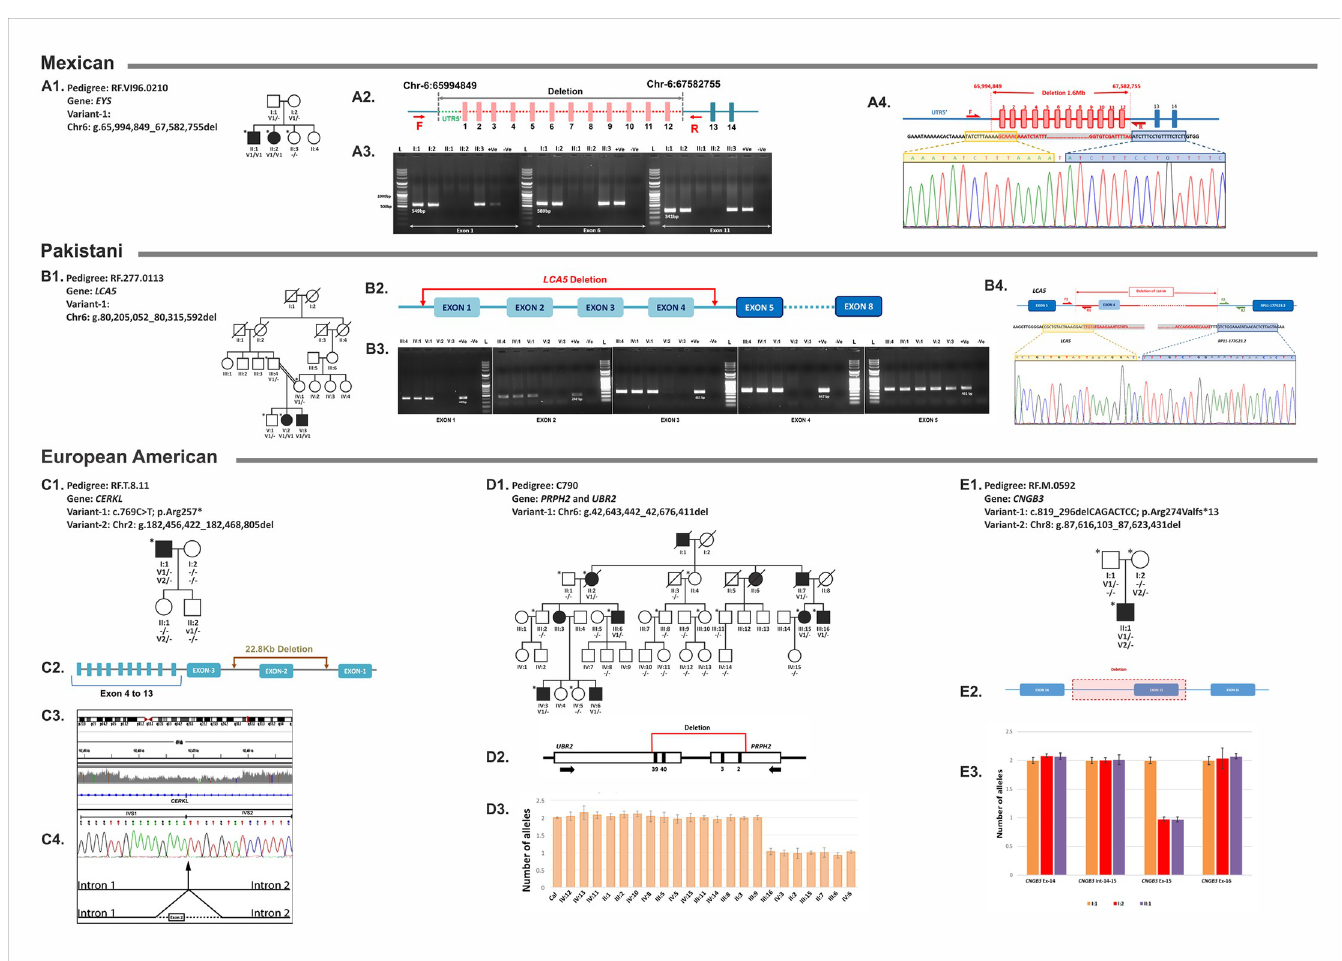
Fig 3. Pedigrees with copy number variations (CNVs). Five unique structural variants were identified in EYS , LCA5 , CERKL , PRPH2 , and CNGB3 in five different pedigrees, one with dominant macular degeneration and four with recessive retinal degeneration. (A1) 1.6Mb homozygous deletion Chr6: g.65,994,849_67,582,755del is segregating with recessive retinal degeneration in a Mexican pedigree RF.V196.0210. (A2) The schematic diagram depicting a 1.6Mb homozygous deletion Chr6: g.65,994,849_67,582,755del encompassing the exons 1 to 12 and about 1.6Mb of 5’-untranslated region of the EYS gene. (A3) PCR amplification of EYS exons 1, 6, and 11 detected the presence of expected size product in unaffected individuals (I:1, I:2, II:3) whereas the presence of PCR product was not observed in two affected individuals (II:1 and II:2). (A4) Amplification with primers flanking the deleted region followed by sequencing revealed the junction point in individual II:1 due to the 1.6Mb deletion. Examination of the sequence flanking the junction point detected paralogous repeat sequences on both sides of the deleted region (blue and yellow boxes). (B1) In a consanguineous Pakistani pedigree RF.277.0113, a 110Kb homozygous deletion in LCA5 (chr6: g.80,205,052_80,315,592del) segregated with the phenotype. (B2) The novel 110Kb homozygous deletion includes 1 to 4 exons of LCA5 . (B3) PCR amplification showed the absence of exon 1 to 4 of LCA5 in both affected individuals while exon 5 is present in all family members. (B4) Amplification with primers flanking the deletion resulted in the generation of the fragment with deletion. Sequencing this PCR product revealed the presence of paralogous repeat sequences flanking the junction point in affected individuals. Sequence marked with yellow and blue rectangles represent the paralogous sequence on both sides of the deleted region. (C1) A previously reported heterozygous stop mutation CERKL p. Arg257 � and a novel heterozygous large 22.8 Kb deletion (Chr2: g.182,456,422_182,479,267del) on chromosome 2, which includes exon 2 of CERKL are observed in trans configuration in the proband of RF.T.8.11. (C2) The schematic diagram shows the 22.8Kb deletion which includes ~10.3Kb of intron 1 and exon 2 (243bp) and 12.3Kb of intron 2 of CERKL gene. (C3) The WGS reads mapped to the deleted region showed decrease in read depth. (C4) Electropherogram showing the sequence of junction fragment generated by amplification with primers flanking the deletion revealed the specific boundaries of the deletion that includes exon 2 of CERKL . (D1) The segregation analysis revealed a heterozygous 33Kb deletion on chromosome 6 (Chr6: g.42,643,442_42,676,411del) segregating with the disease. (D2) A cartoon depicting the deleted region which includes two different genes: exons 39 and 40 of UBR2 and exons 2 and 3 of PRPH2 present in opposite orientation (D3) Analysis of 7 affected and 15 unaffected members using qPCR confirmed the presence of the heterozygous deletion on chromosome 6 in affected members and not in unaffected relatives. (E1) A set of compound heterozygous deletions including a novel 7Kb deletion (Chr8: g.87,616,103_87,623,431del) and a previously known 7bp deletion p. Arg274Valfs � 13 in CNGB3 gene were observed in RF.M.0592 pedigree with a single affected individual. (E2) The novel 7Kb heterozygous deletion (Chr8: g.87,616,103_87,623,431del) (Pink rectangle) includes coding exon 15 of CNGB3 . (E3) qPCR analysis confirmed the presence of the heterozygous deletion of CNGB3 exon 15 in II:1, which was inherited from the mother (I:2). The asterisk indicates the availability of whole-genome sequencing